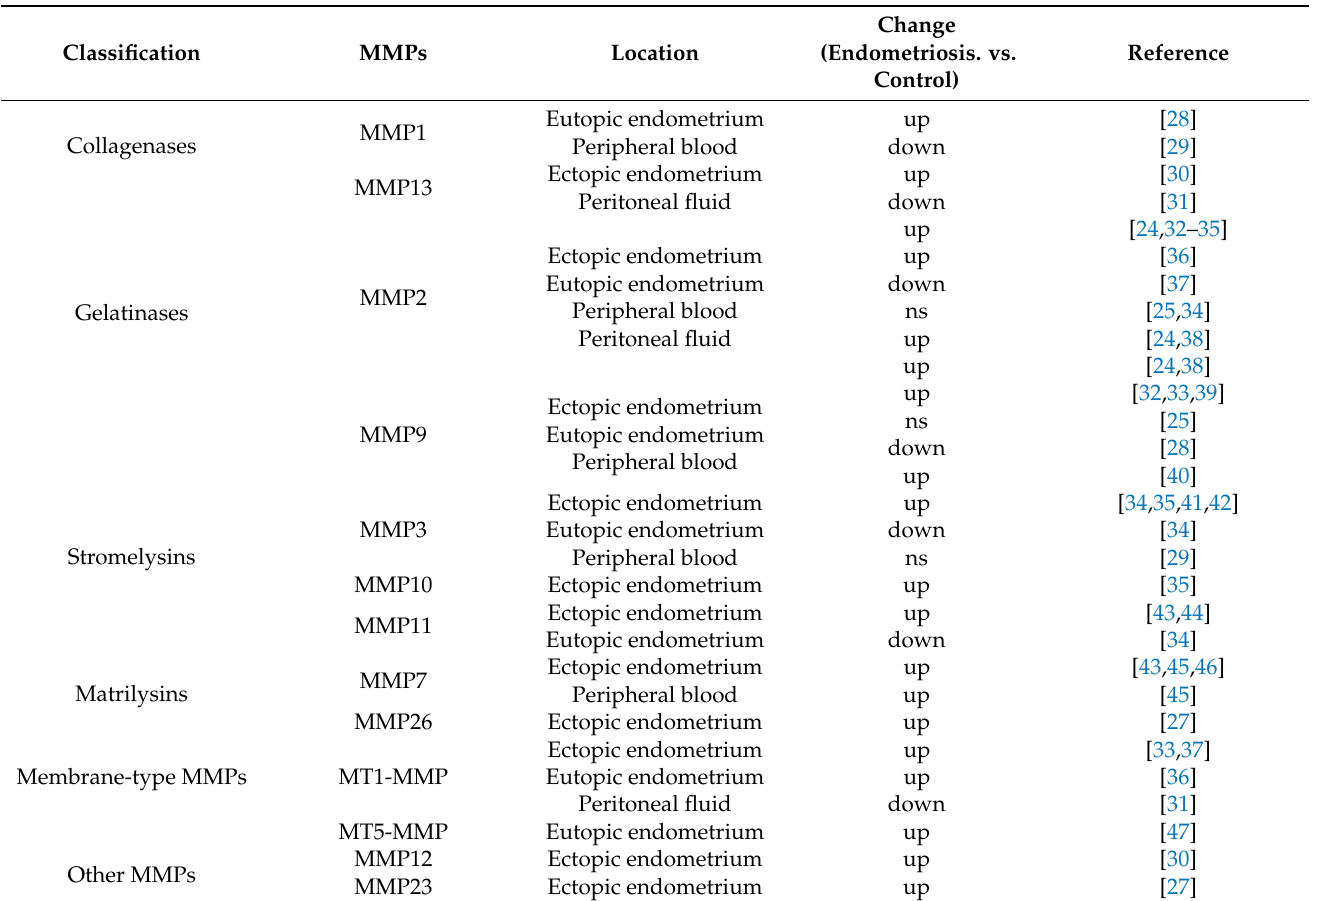
Table 1. Changes in MMPs in